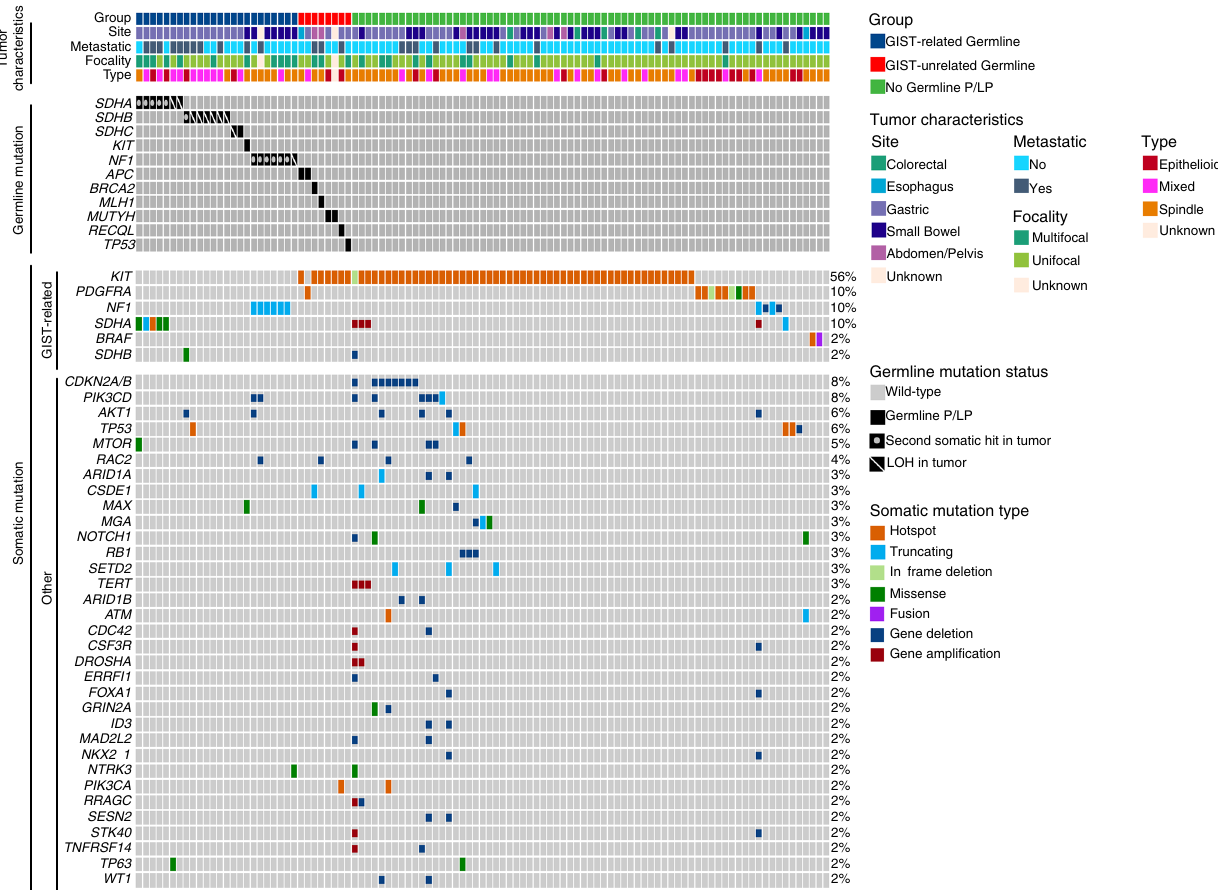
Fig. 1 Mutational landscape of GISTs from 103 patients who received germline genetic testing. Tumor characteristics (site, metastasis status, focality, type) and the effects of somatic mutations are color coded according to the legend. LOH is displayed by a diagonal bar and second somatic mutation (second somatic hit) is displayed by a dot. The numbers on the right side of each row refer to the percentage of tumors with that given gene mutation in the overall cohort of 103